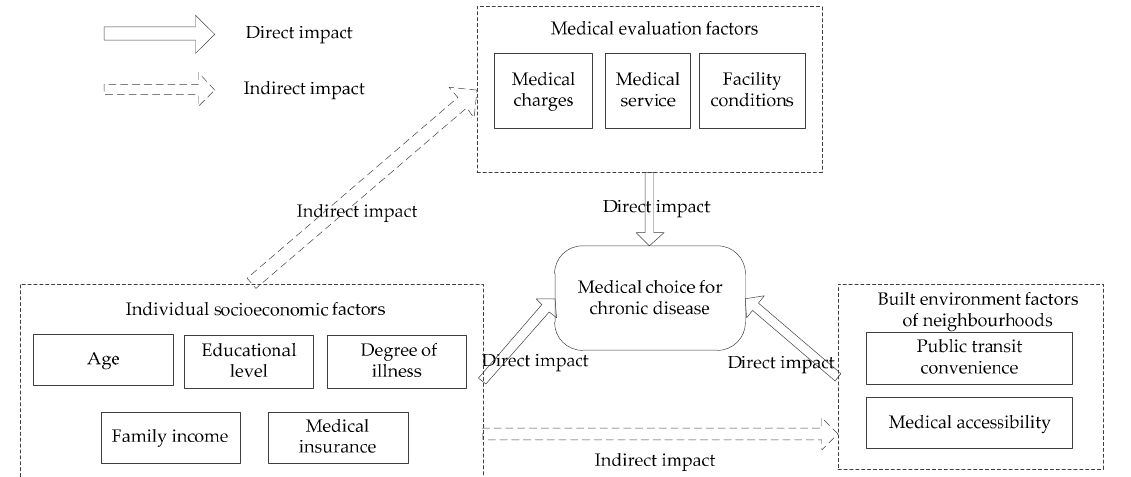
Figure 6. The mechanisms influencing medical choices for chronic diseases in Gaoyou